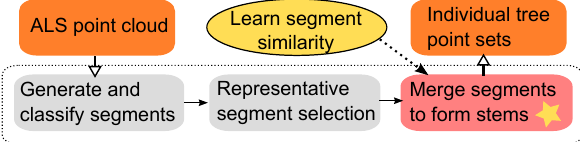
Figure 1: Overview of fallen tree